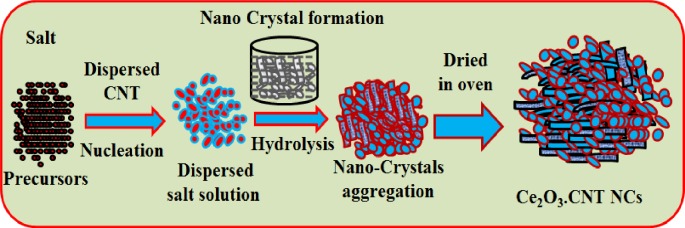
Growth mechanism of Ce2O3.CNT NCs.